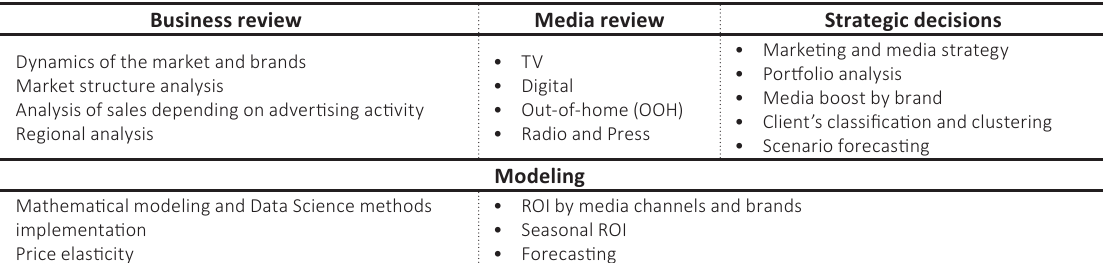
Source: Developed by the authors.